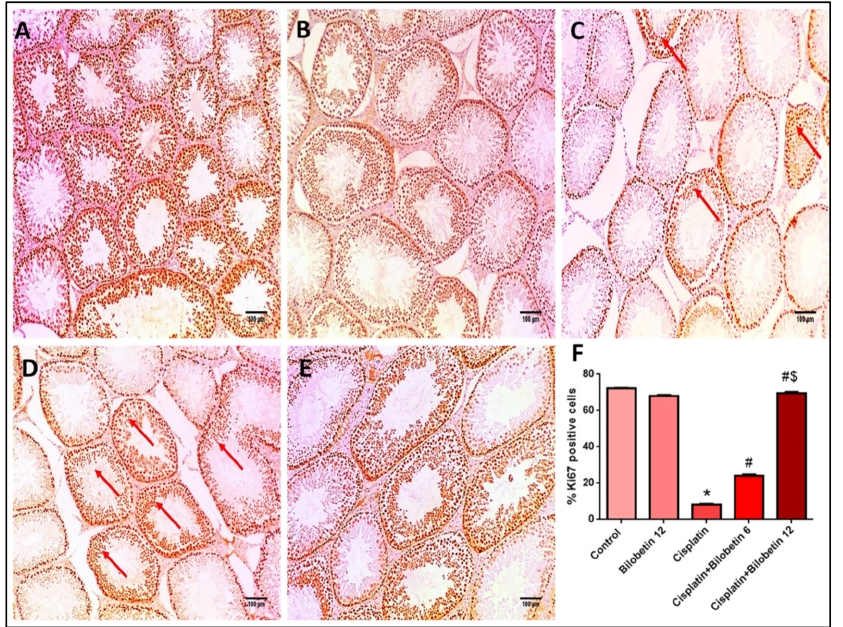
Figure 4. Effects of Bilobetin treatment on immunohistochemical staining of Ki67. ( A ) Section of testis of the normal control rat showed strong Ki67 staining (more than 50%) of spermatogenic cells ( ×